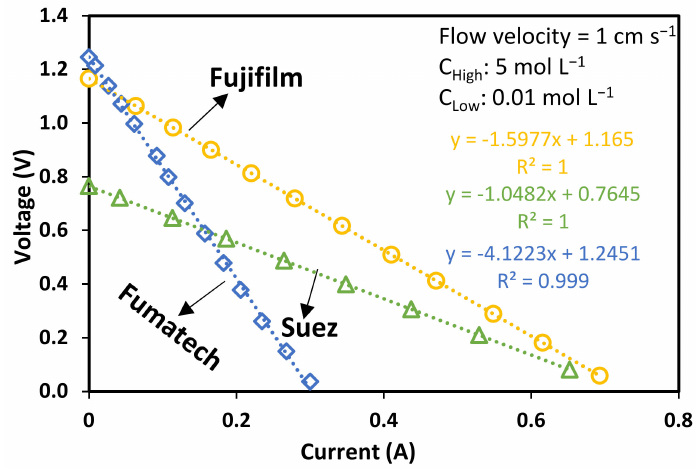
Figure 4. Polarization curves obtained with each IEMs set adopted in the study. The equation reported in the box shows, with reference to Equation (2), the values of R stack (angular coefficient), and OCV (y − intercept).